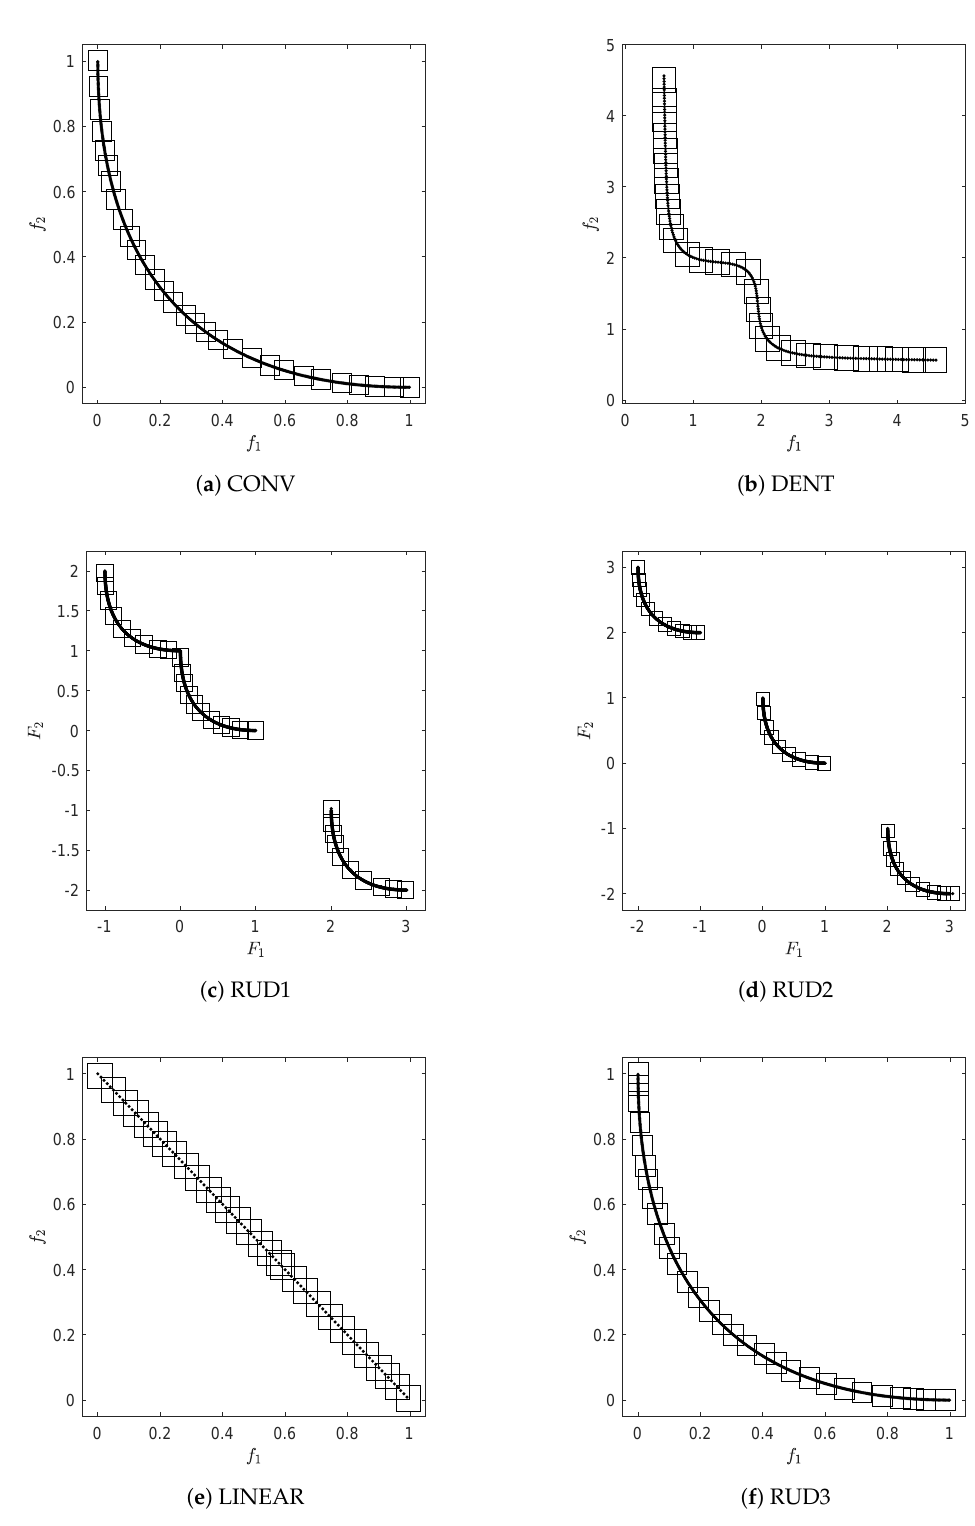
Figure A1. The box coverings C ( A f ) for the final archives incidate that the Hausdorff distance between F ( A f ) and the Pareto fronts is less than the final value ∆ f computed by ArchiveUpdateHD for all test